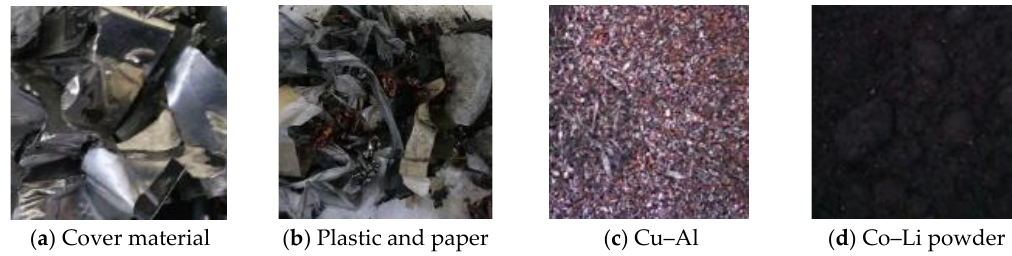
Figure 4. Fractions obtained from the crushing and sieving of batteries.